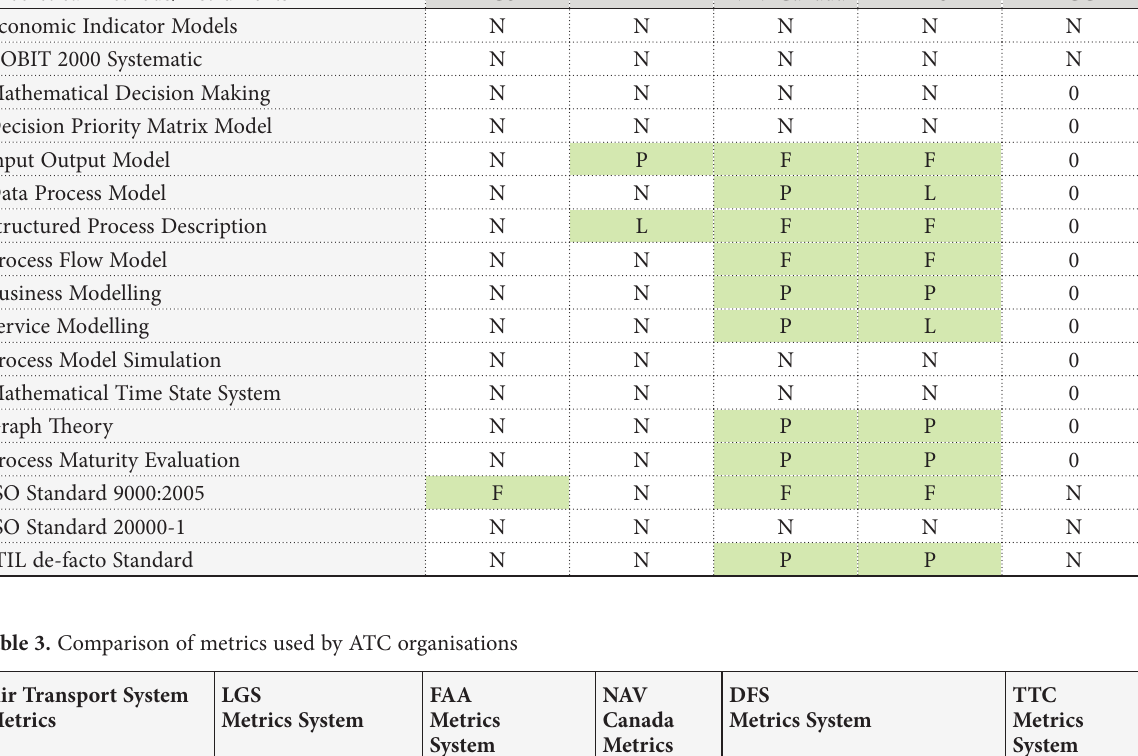
Table 2. Utilisation of methods and instruments at ATC organisations Theoretical Methods/Instruments